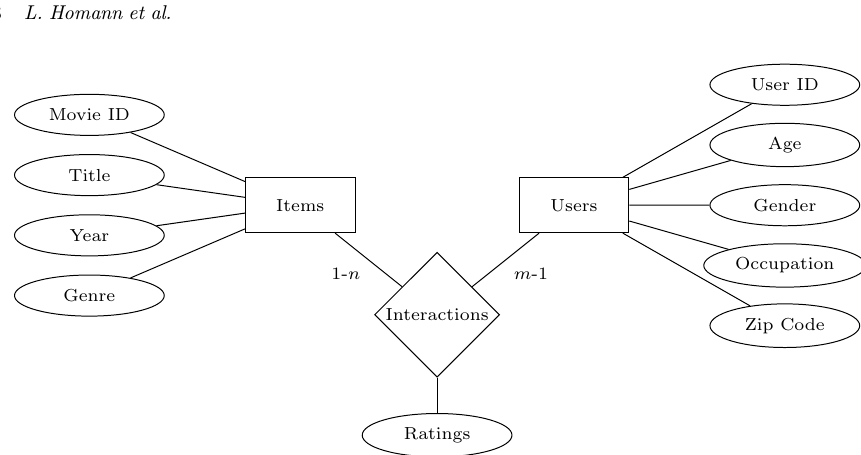
Fig. 4. Entity – Relationship Model describing our running